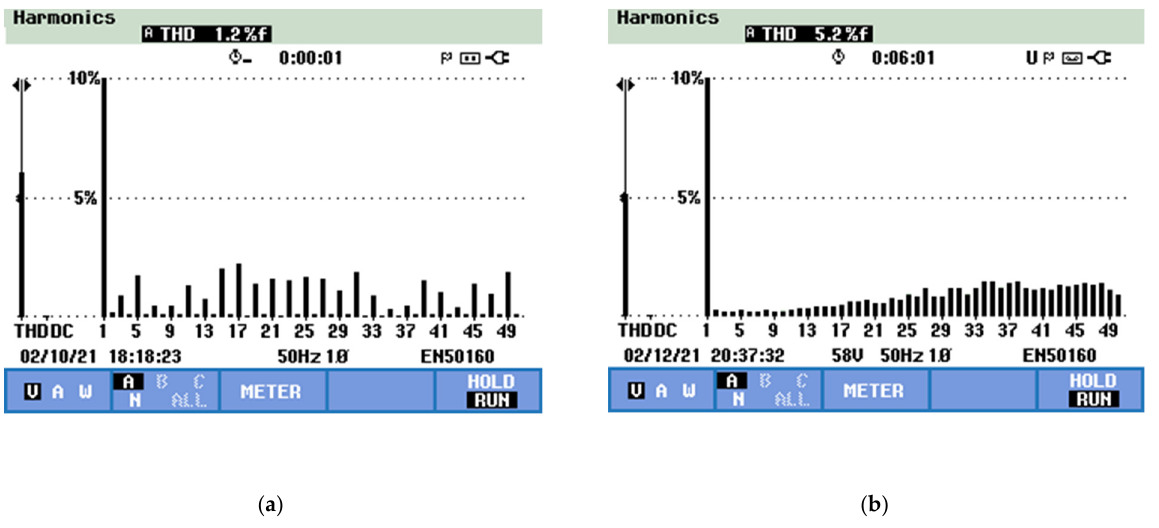
Figure 13. Frequency spectrums at h = 0.03 for ( a ) load current ( b ) load voltage.